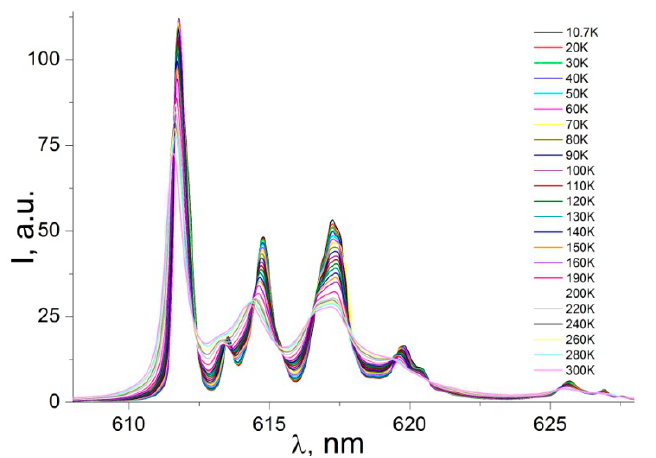
Figure 8. PL emission spectra of powder sample: electric dipole transition 5 D 0 → 7 F 2. For example, at 10.7 K one can distinguish the splitting of this transition into more than six components. This is another indication of the existence of two nonequivalent, nearly identical coordination environments of Eu 3+ in the matrix. The hypersensitive transition 5 D → 7 F 0 2 is much more intense compared to the magnetic dipole transition the ratio of the integrated intensities of two emission bands I( 5 D 0 - 7 F 2 )/I( 5 D 0 - 7 F 1 )